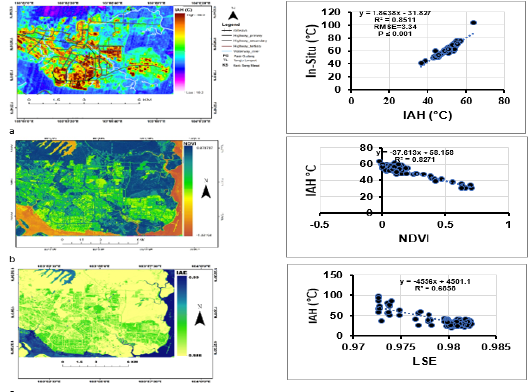
Figure 5. Spatial distribution of IAH and surface indices for Pasir Gudang.